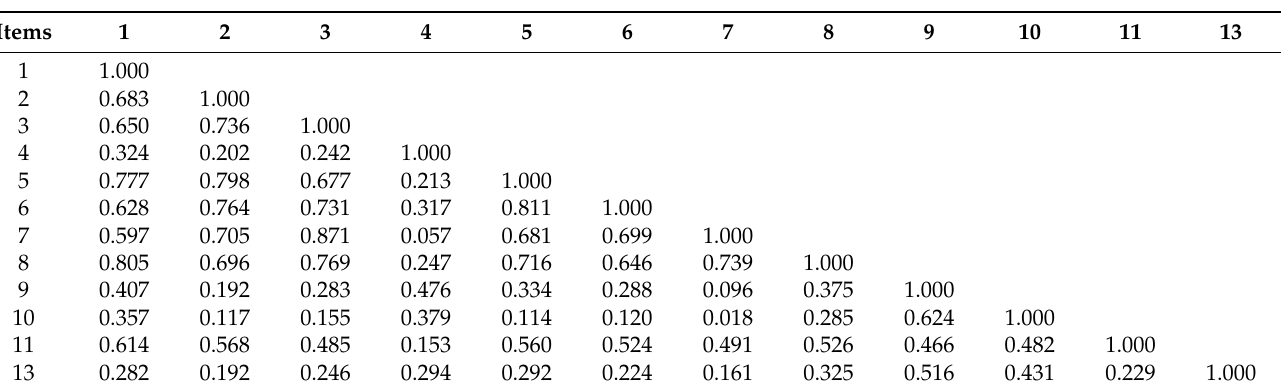
Table 3. Polychoric correlation matrix for 12